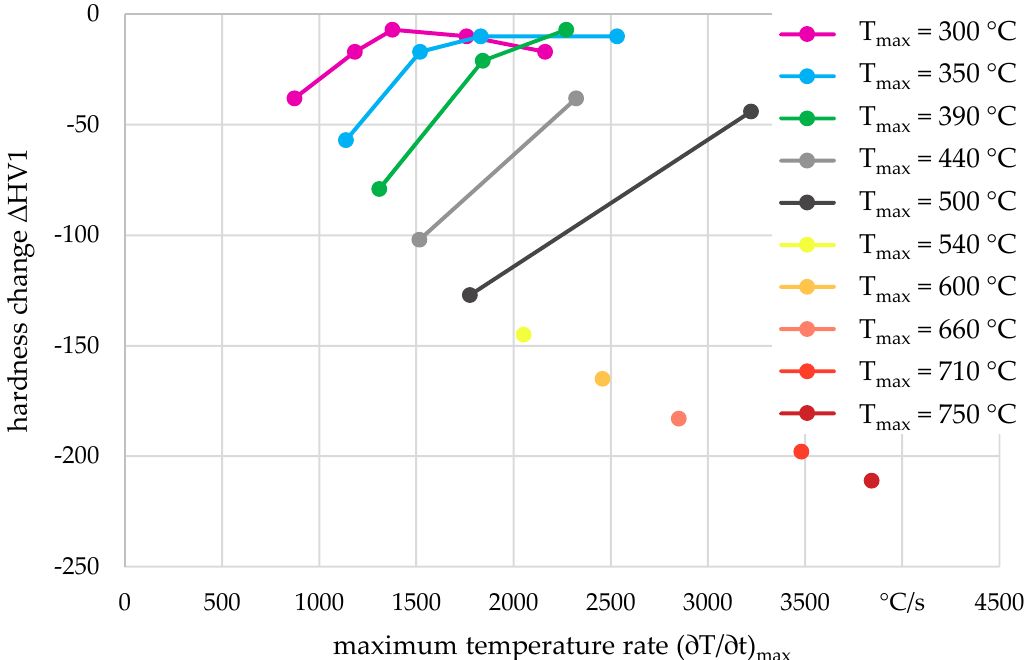
Figure 11. Hardness change dependent on the maximum temperature rate for given maximum temperatures. For the given maximum temperatures, an increase in the maximum temperature rate resulted in a decreasing reduction in the hardness change. This can be